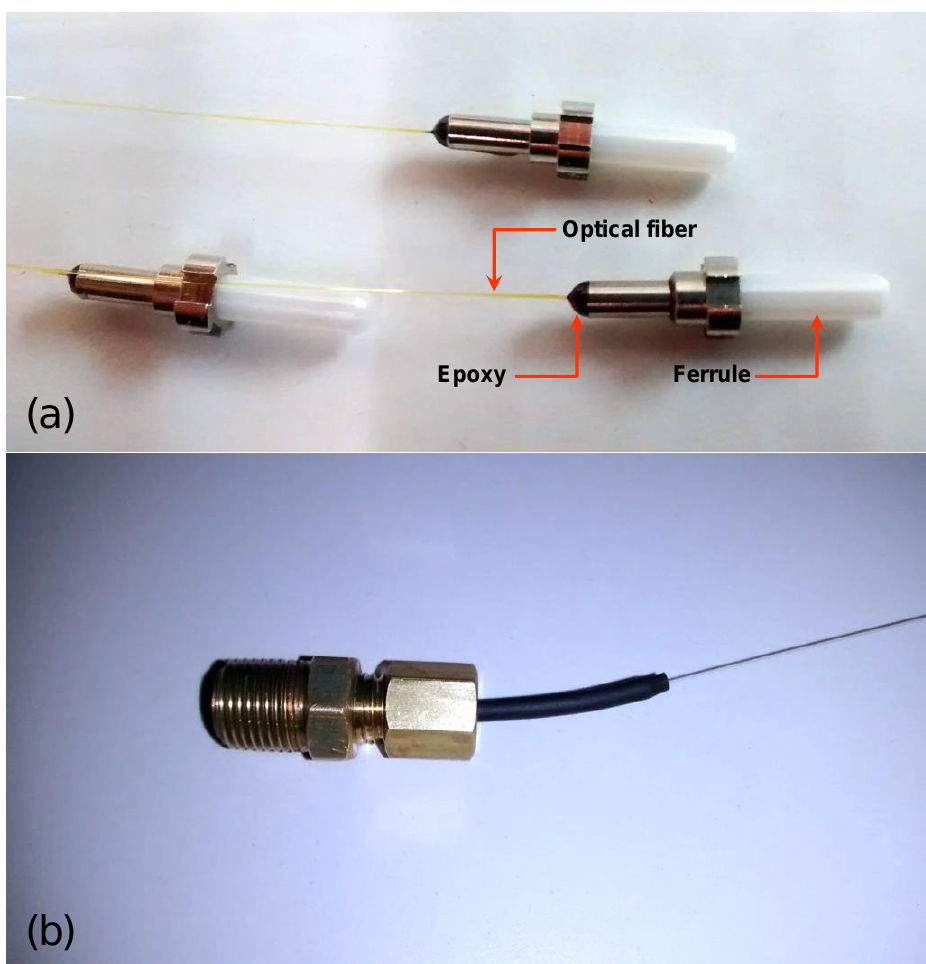
Figure 2. ( a ) Optical fiber ferrules assembled with optical fiber and the high temperature epoxy and ( b ) a pressure connector using the sealed ferrules.